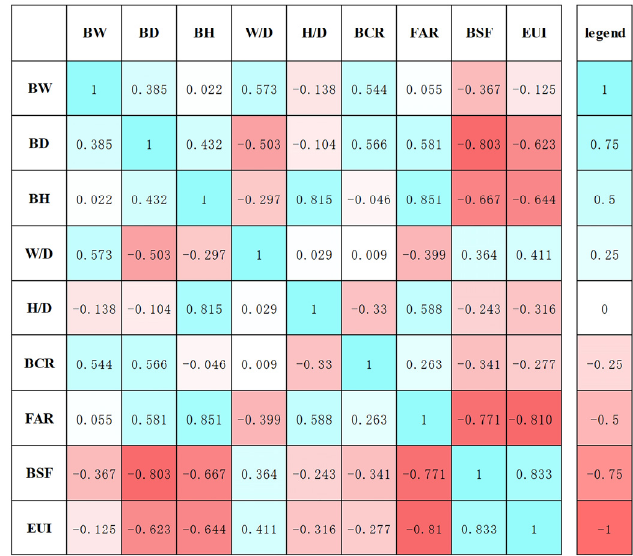
Figure 20. Thermal matrix of correlations between block morphological parameters and EUI.